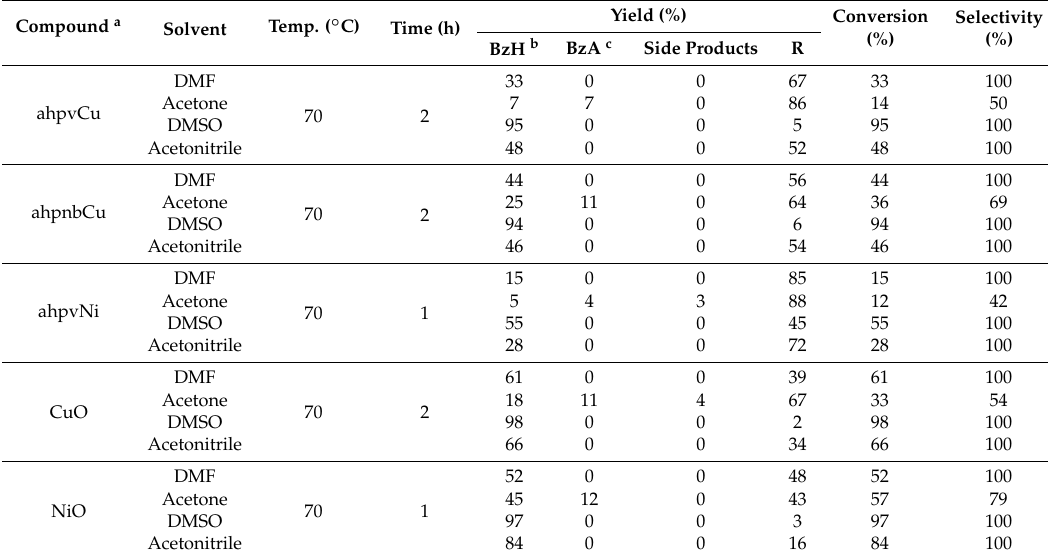
Table 3. Summary of the optimized parameters for oxidation of BzOH using the five prepared